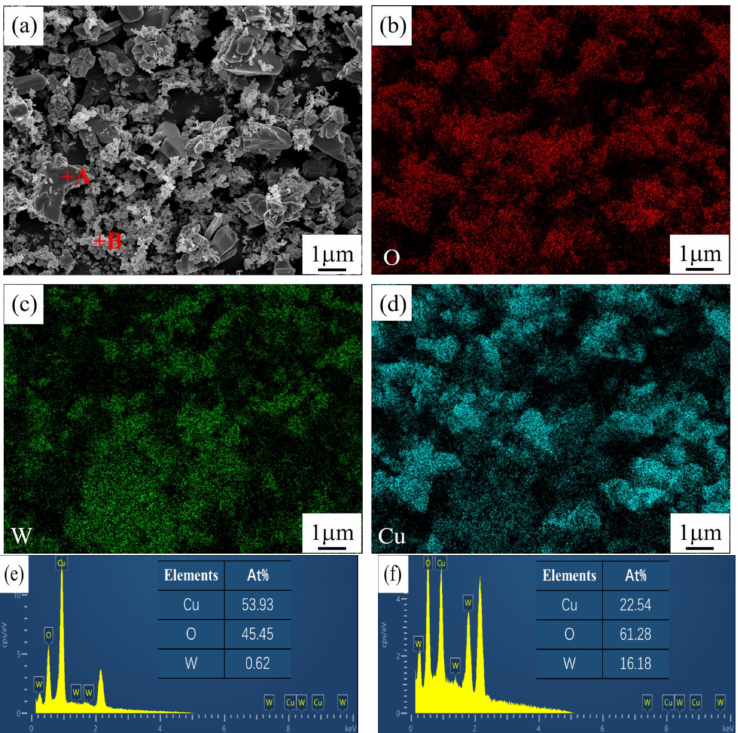
Figure 10. EDS distribution diagram of the larger version of area A in Figure 9c: ( a ) SEM; ( b – d ) dis- tribution of elements; ( e ) EDS spectrum of point A; ( f ) EDS spectrum of point